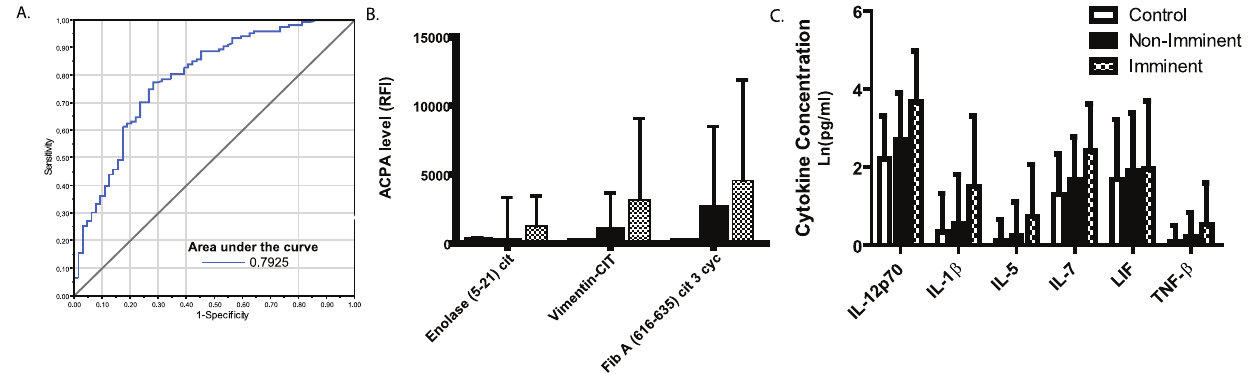
Figure 3. Prediction of imminent RA using multiplex biomarkers. Multiple logistic regression was performed to identify markers from the reduced set of 21 antibodies and 38 cytokines which could classify pre-clinical RA subjects as being within 2 years of the onset of clinical RA. 5-fold cross validation was performed and common markers selected for final validation. A, Demonstrated is a receiver operating characteristic (ROC) curve using the panel of markers listed in table 3. B–C, Mean and standard deviation of values for each individual autoantibody (B) or cytokine (C) contributing to prediction of imminent onset RA as measured among controls, those RA patients at a timepoint greater than 2 years prior to RA onset, or those within 2 years of clinical RA onset.